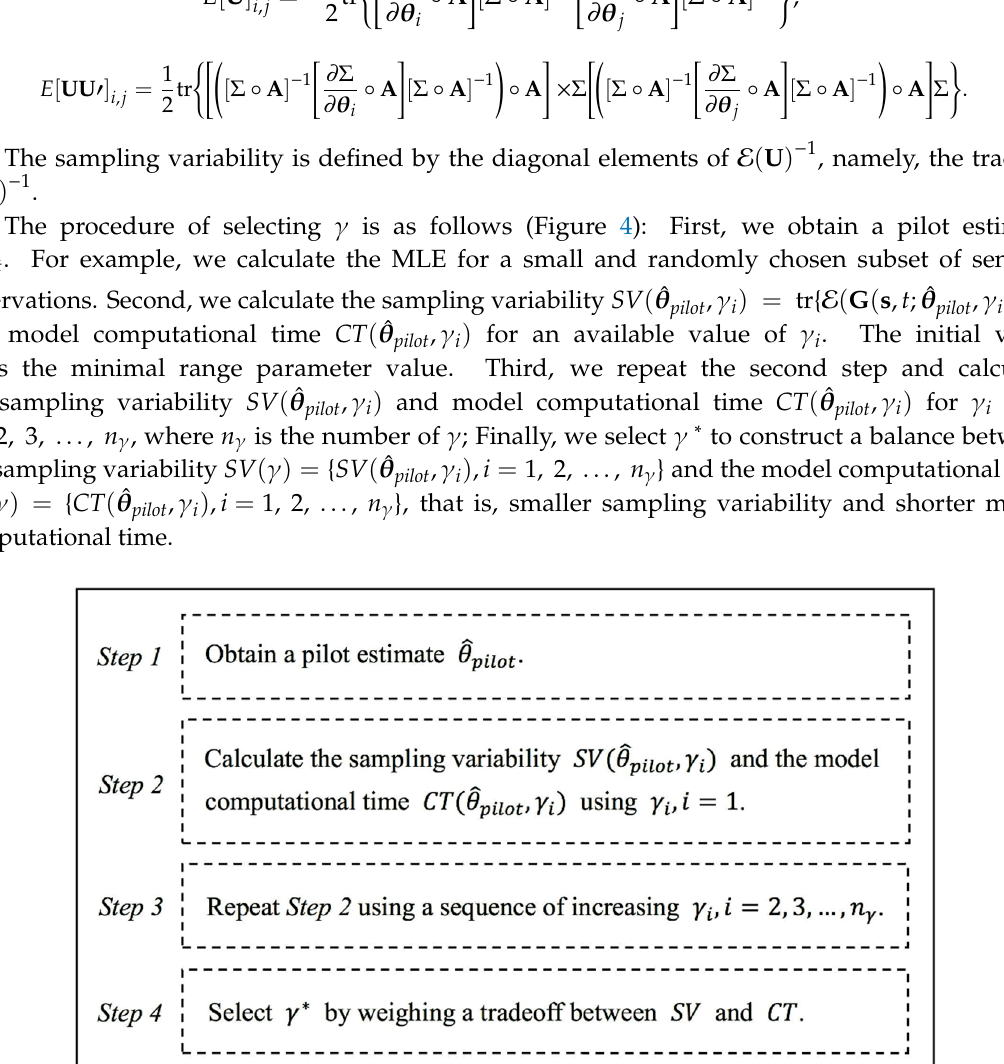
Figure 4. The criterion to determine the range parameter 𝛾 .